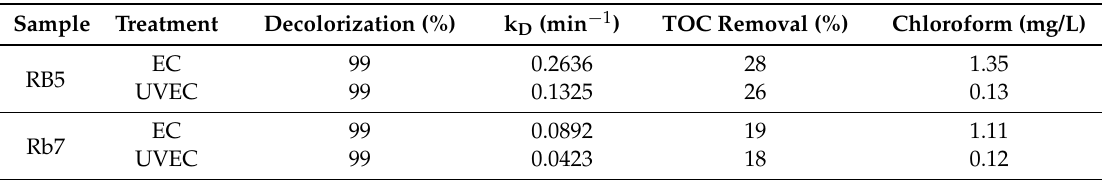
Table 3. Results of EC and UVEC treatments of dyes.